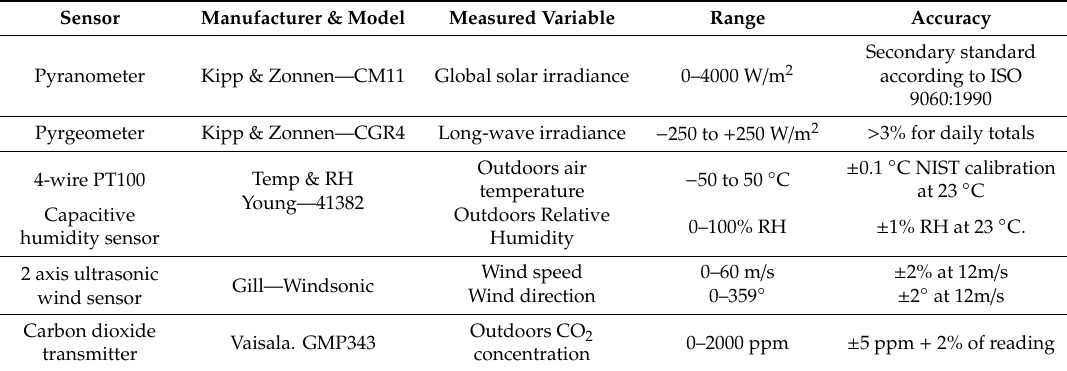
Table 3. Summary of the instrumentation used for outdoor environmental